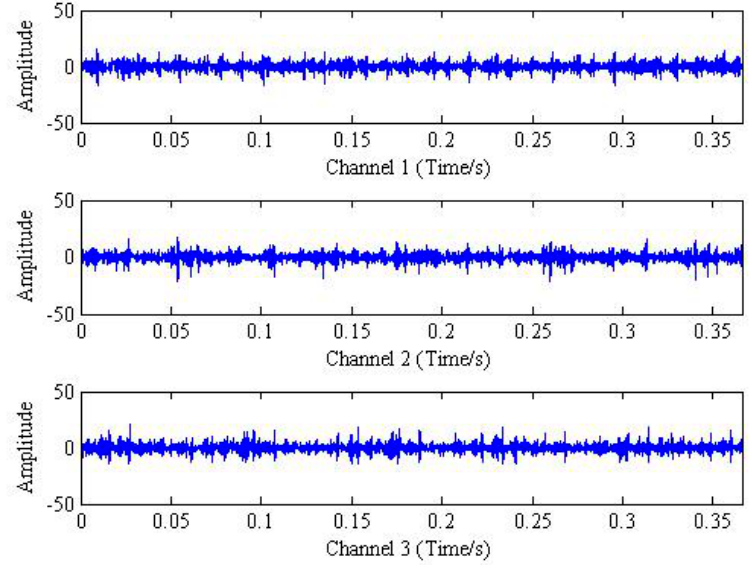
Figure 8. The time domain plot of measured trivariate signal.